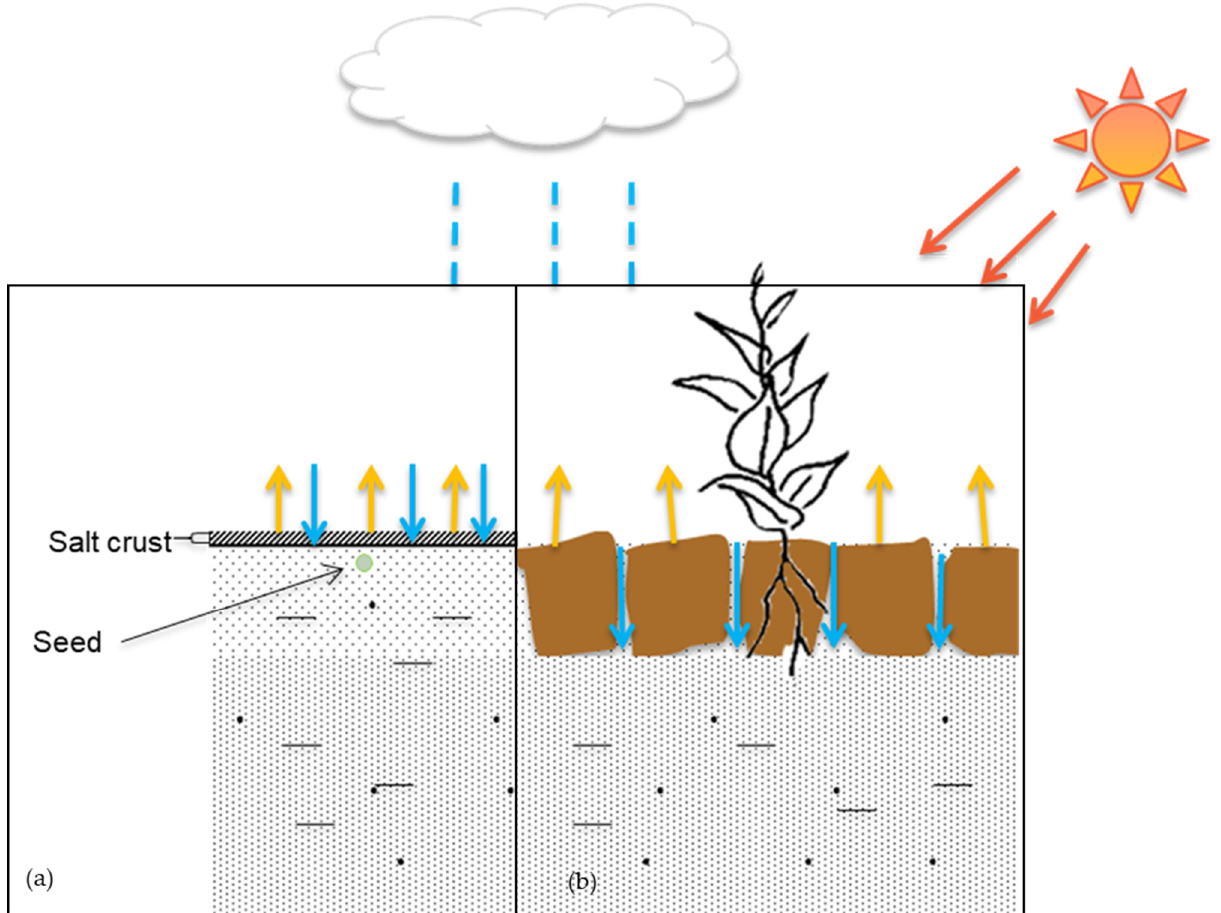
Figure 2. Conceptual model of reclamation of salt-affected area ( a ) before reclamation, ( b ) after reclamation .